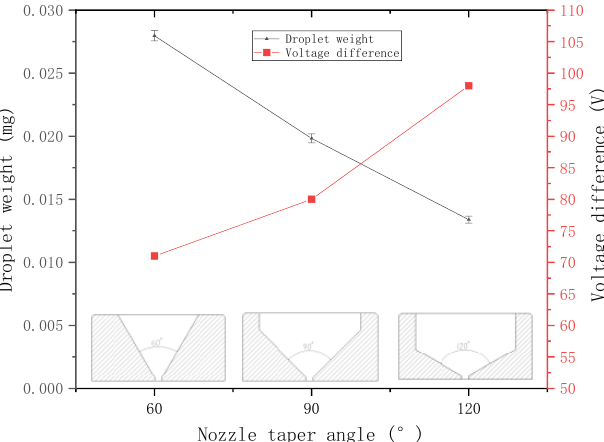
Figure 17. Relationship between the droplet weight, minimum voltage difference, and nozzle taper angle.